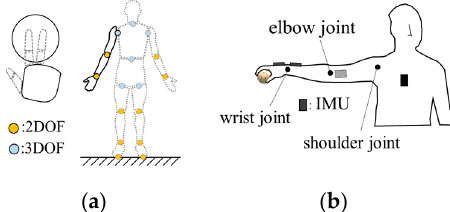
Figure 1. A schematic representation of ( a ) a model of the upper limb with the ball, and ( b ) initial configuration of the participant during the pitching motion in experiments. ( a ) Upper limb model; ( b ) the locations of inertial measurement units (IMUs) on the segments and initial configuration at the start of the pitching motion.